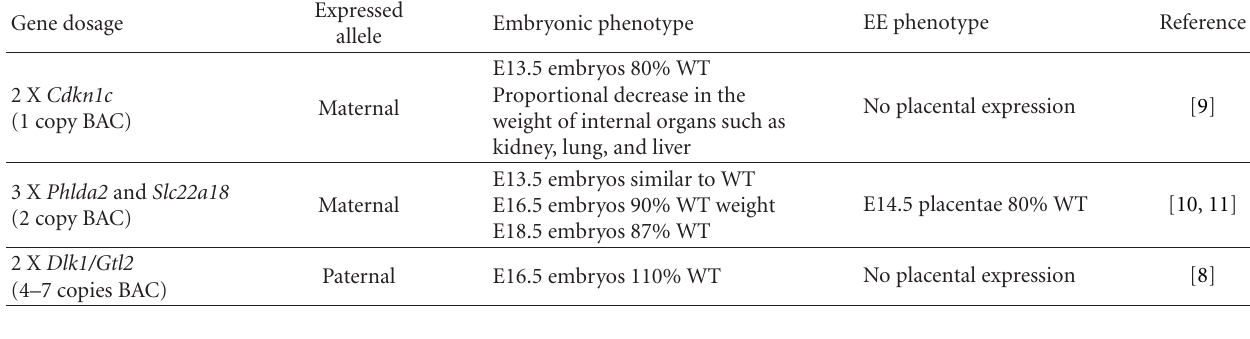
Table 2: Functional consequence in transgenic overexpression models.